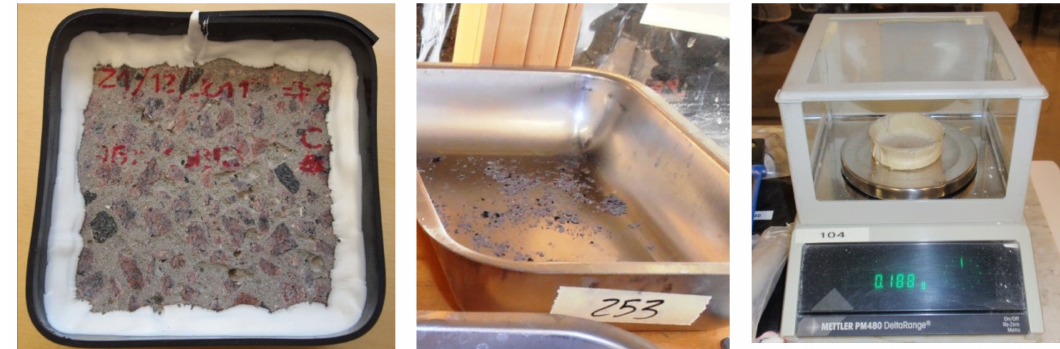
Figure 8. Left : Example of specimen after 112 freeze / thaw cycles (specimen of Mix 2%-25% GGBS, 4.5% Air, k = 0.6); Center : Scaled-o ff material collected on a steel vessel; Right : Determination of the mass of scaled material.